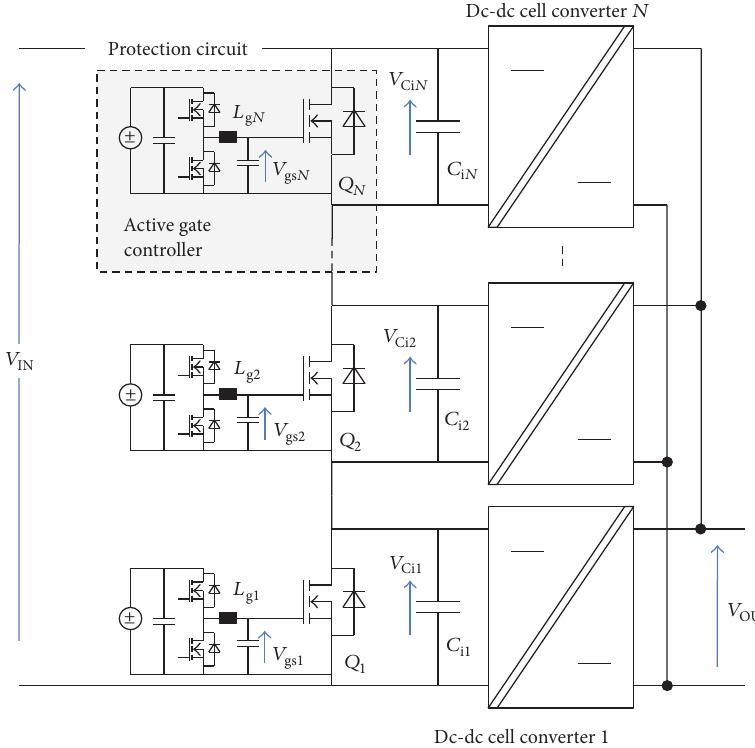
Figure 4: ISOP multicell dc-dc converter and active gate controlled SiC protection switch.